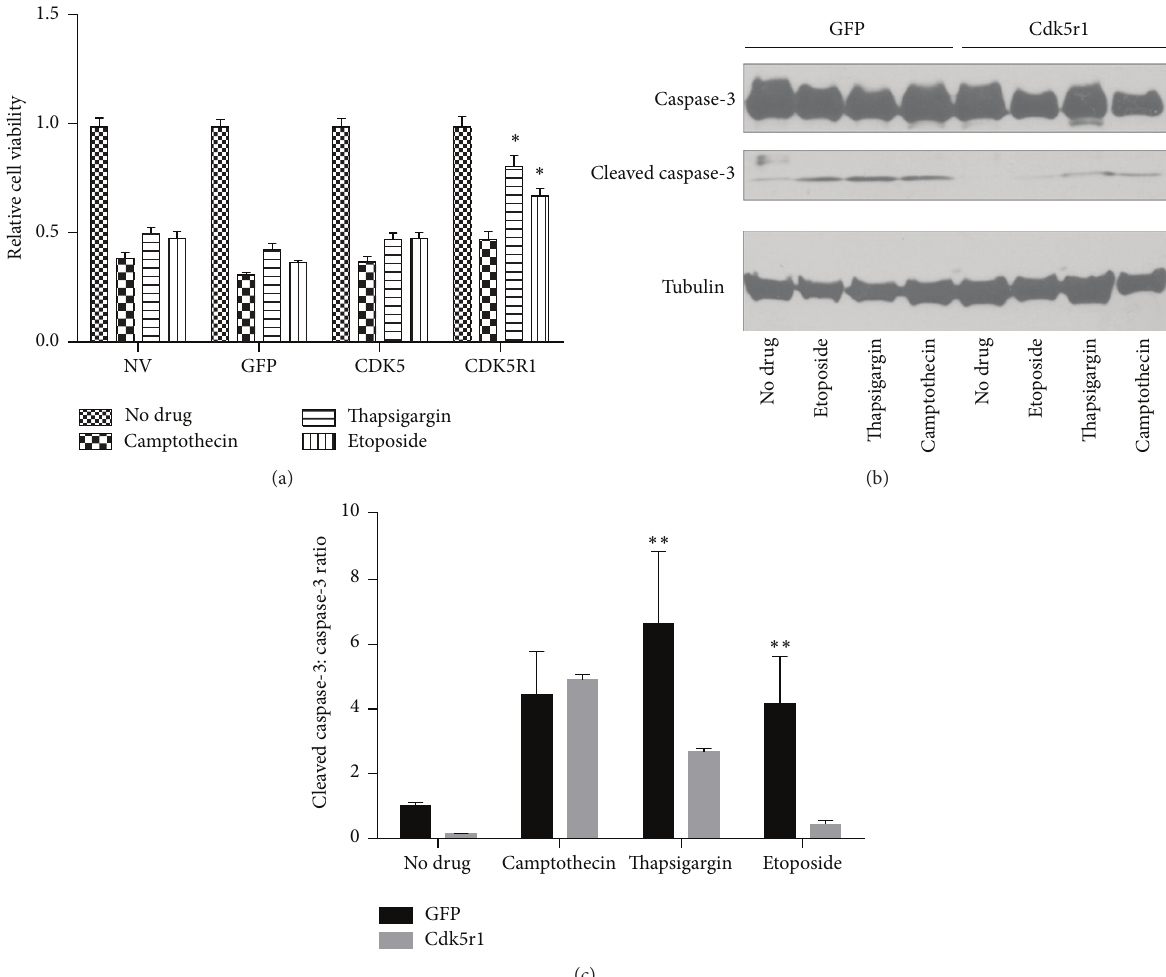
Figure 5: Cdk5r1 overexpression protects INS-1 𝛽 -cells from apoptosis. (a) 832/13 INS-1 cells were transduced with AdCMV-GFP, AdCMV- Cdk5, or AdCMV-Cdk5r1. Twenty-four hours after adenoviral transduction, cells were cultured for 18 hours in the presence of camptothecin, thapsigargin, etoposide, or the vehicle control. Cell counts were completed 18 hours after drug treatment. Cell viability was determined by comparing the untreated population to the treated population. Cells overexpressing Cdk5r1 presented greater viability when treated with thapsigargin or etoposide than control cells. Data represent the mean ± SEM of nine independent experiments. p value represents the comparison between Cdk5r1- and GFP-treated 832/13 cells. Cells were transduced with AdCMV-GFP or AdCMV-Cdk5r1 and subsequently treated with camptothecin, thapsigargin, or etoposide. Western blotting for total caspase-3 or cleaved caspase-3 was queried to determine activation of apoptosis pathway. Representative western blot (b) and quantitation (c). Data represent the mean ± SEM of four independent experiments. ∗ 𝑝 ≤ 0.01 ; ∗∗ 𝑝 ≤ 0.01